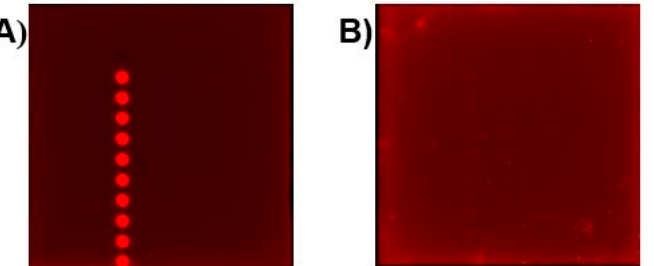
Figure 1. ( A ) Spotted and blocked HSP90 α with attached Cy5-ATP. ( B ) In the presence of 1 µM radicicol, there is incomplete inhibition of binding of Cy5-ATP. Schematic overview of a highly miniaturized QD sensor for flexible applications.